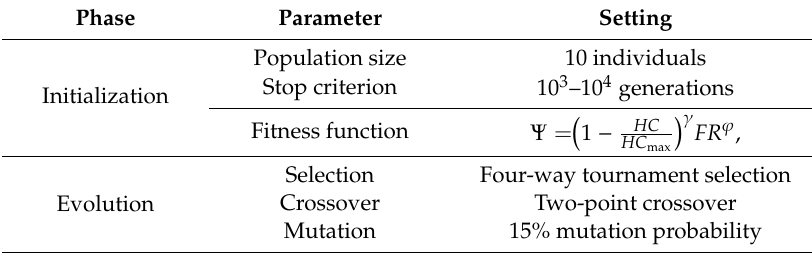
Table 6. Continuous genetic algorithm (CGA) parameters for logistic network